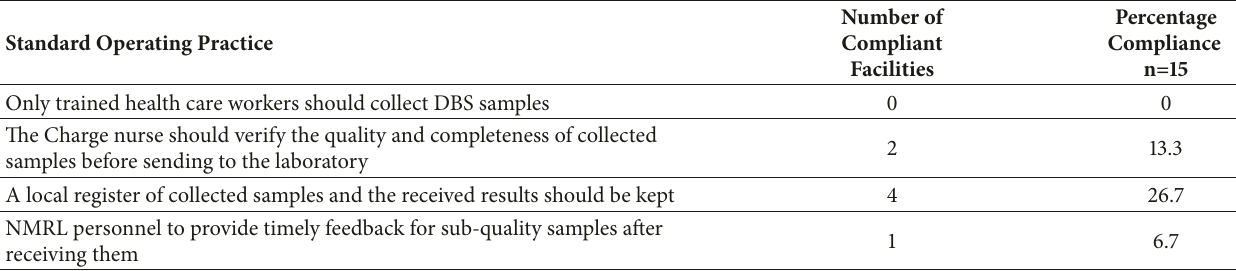
Table 2: Compliance with Standard Operating Procedure (SOP) for DBS Sample Collection by Mhondoro, Zvimba and Chegutu Districts, 2016. S tanda r d Ope r atin g P r